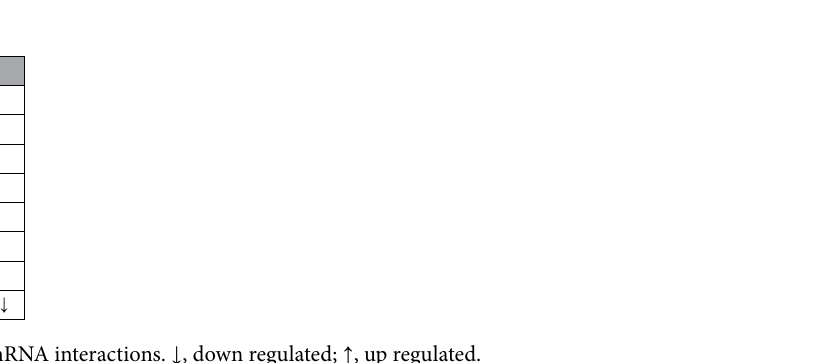
Table 5. MicroRNA/mRNA interactions. ↓ , down regulated; ↑ , up regulated.